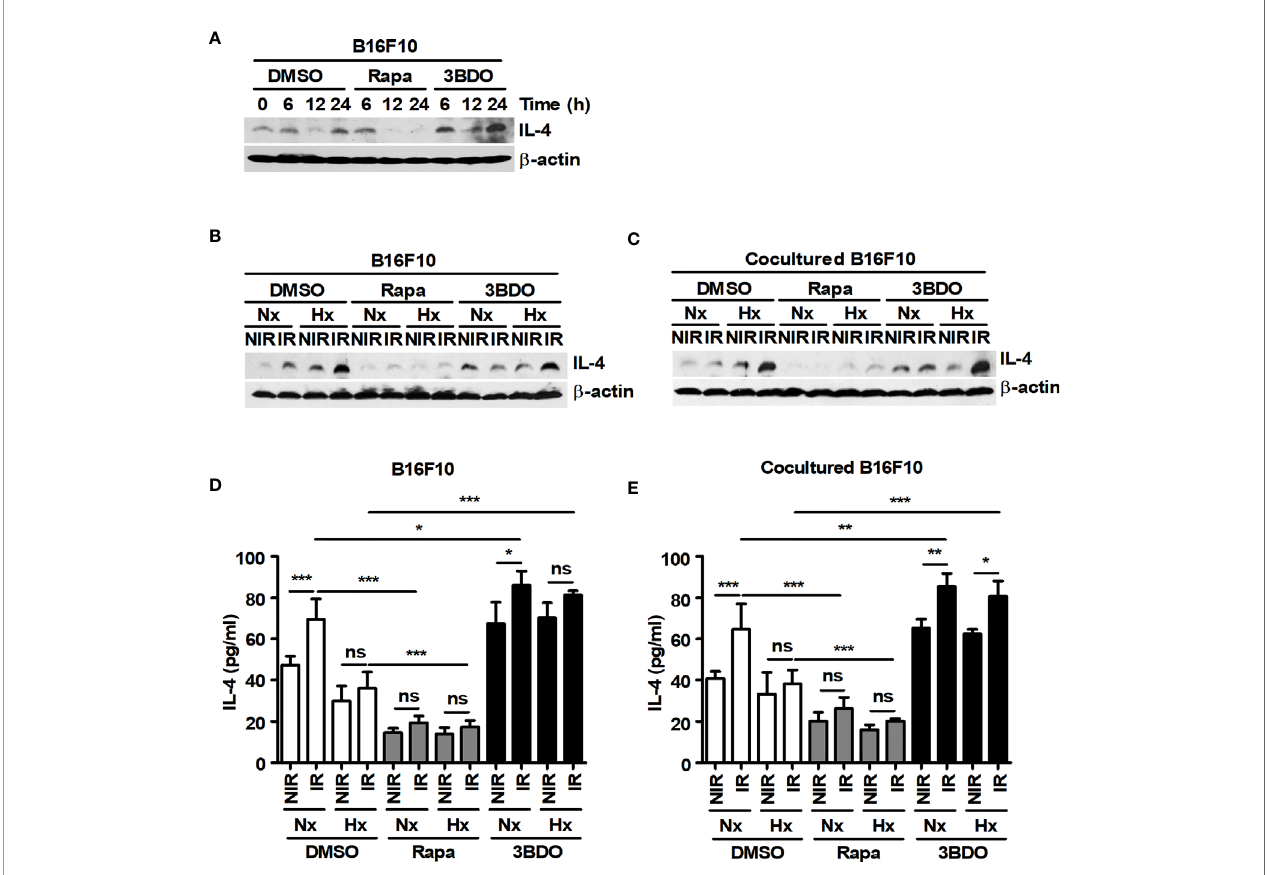
FIGURE 4 | Pharmaceutical regulation of mTOR activation affects the expression and secretion of IL-4 in B16F10 cells. (A) B16F10 cells were treated with DMEM containing DMSO, 100 nM rapamycin or 100 nM 3BDO for the indicated times. Intracellular IL-4 levels were detected by western blotting. (B – E) B16F10 cells cultured alone or cocultured with BMDMs were incubated in the presence of 100 nM rapamycin or 100 nM 3BDO under the indicated conditions for 21 h. Intracellular IL-4 levels were detected by western blotting (B, C), and secreted IL-4 was analyzed by ELISA (D, E) . The bars and error bars represent the mean ± SD; * P < 0.05; ** P < 0.01; *** P < 0.001; ns, not signi fi